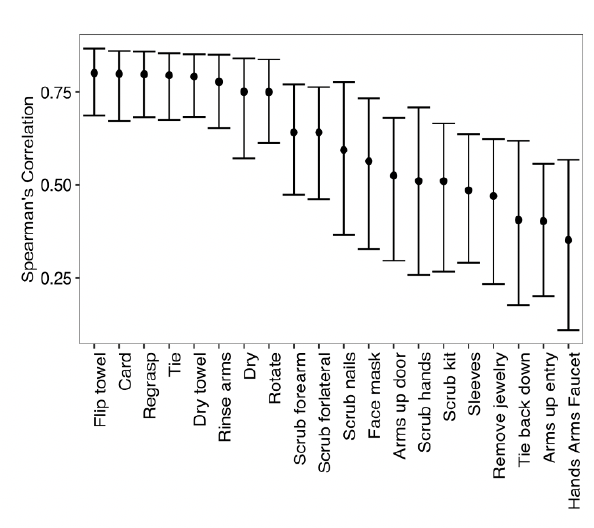
Figure 4. Spearman Rank Correlation Coefficient with 95% Confidence Intervals for each Checklist Item.